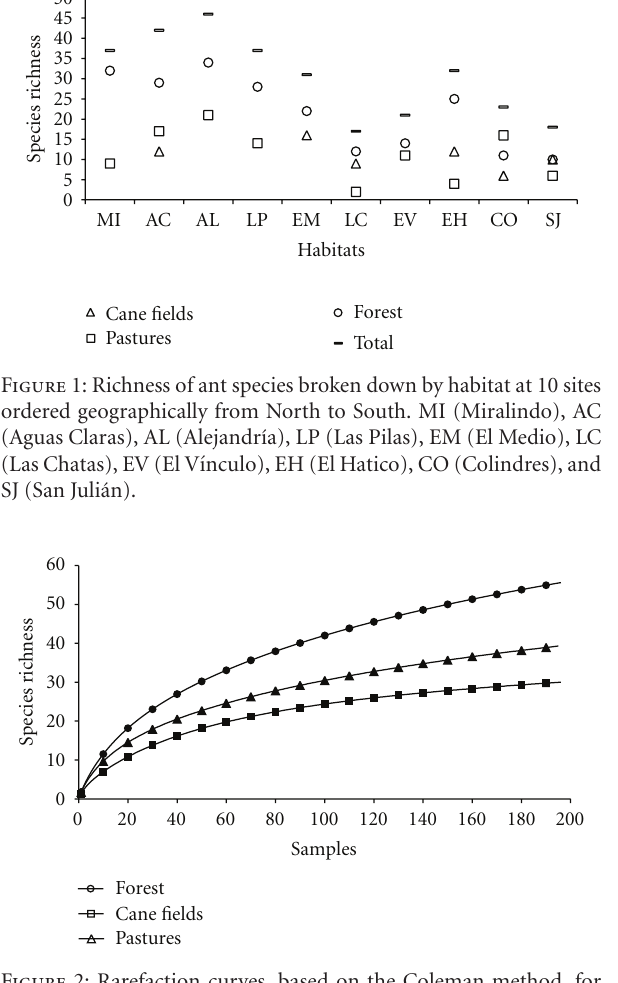
Figure 2: Rarefaction curves, based on the Coleman method, for species of ants captured at tuna-fish baits in three habitats within the tropical dry forest region. For purposes of clarity, the confidence intervals (95%) and the SD are omitted in the figure.